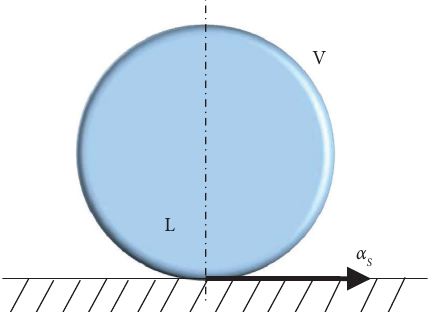
Figure 15: Liquid on the solid surface at β � 180 ° forms spherical